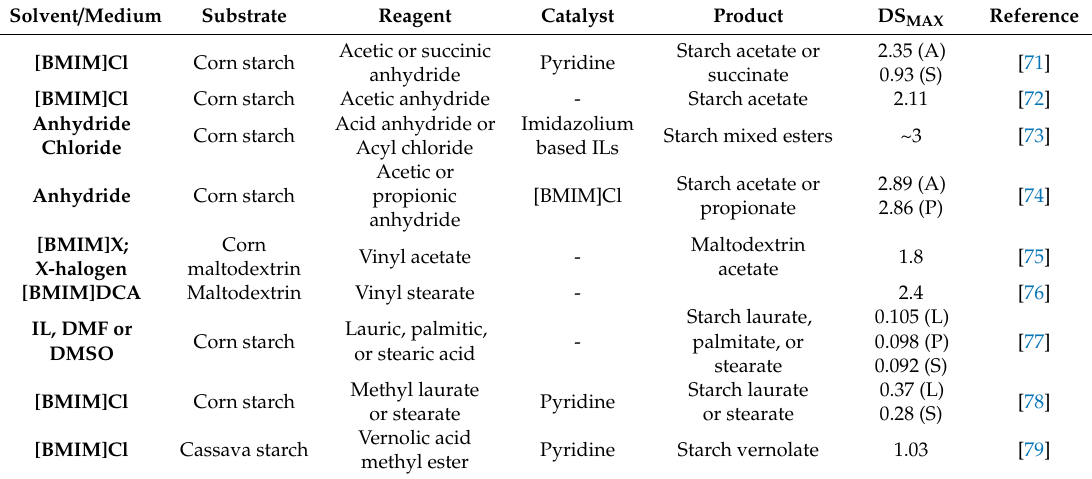
Table 3. ILs used for conventional esterification of